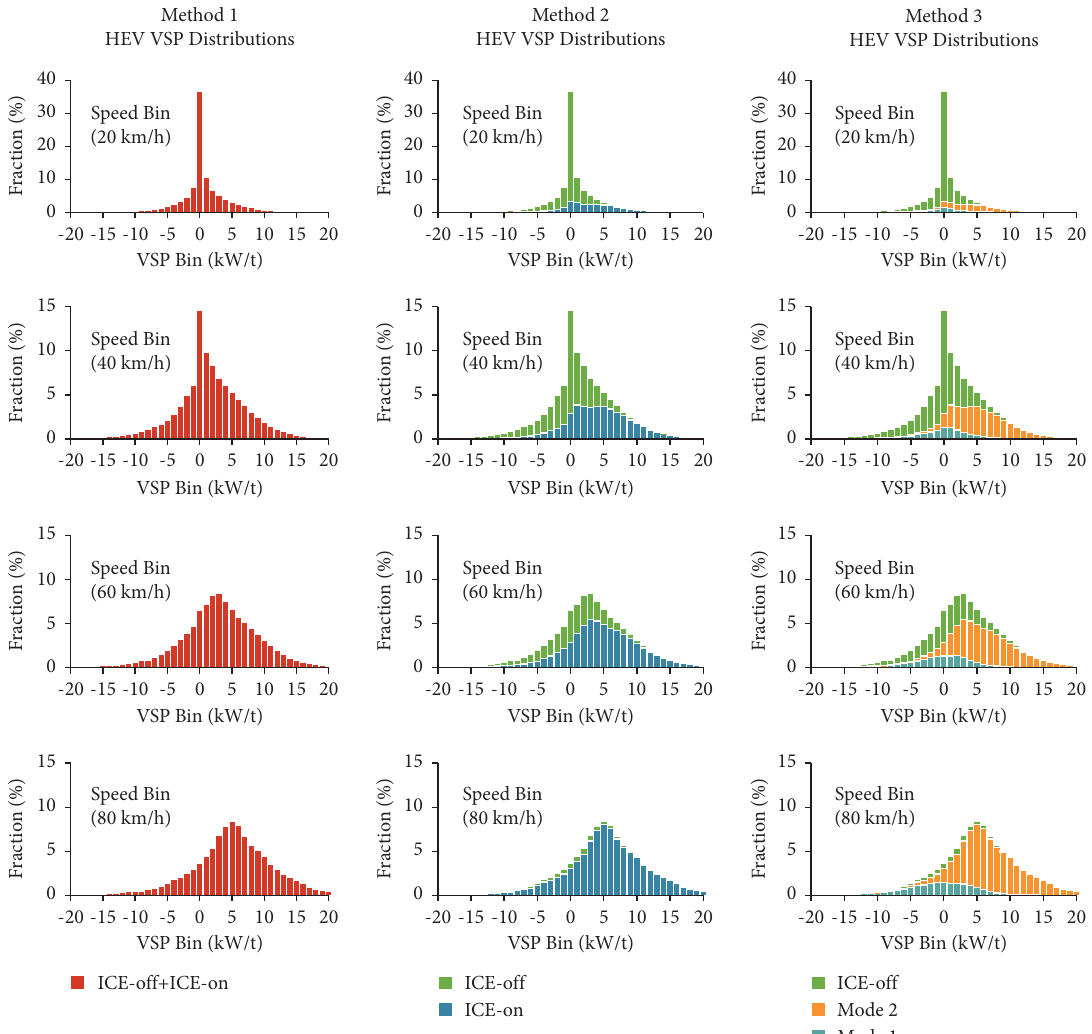
Figure 8: Te HEV VSP distribution with method 1 through